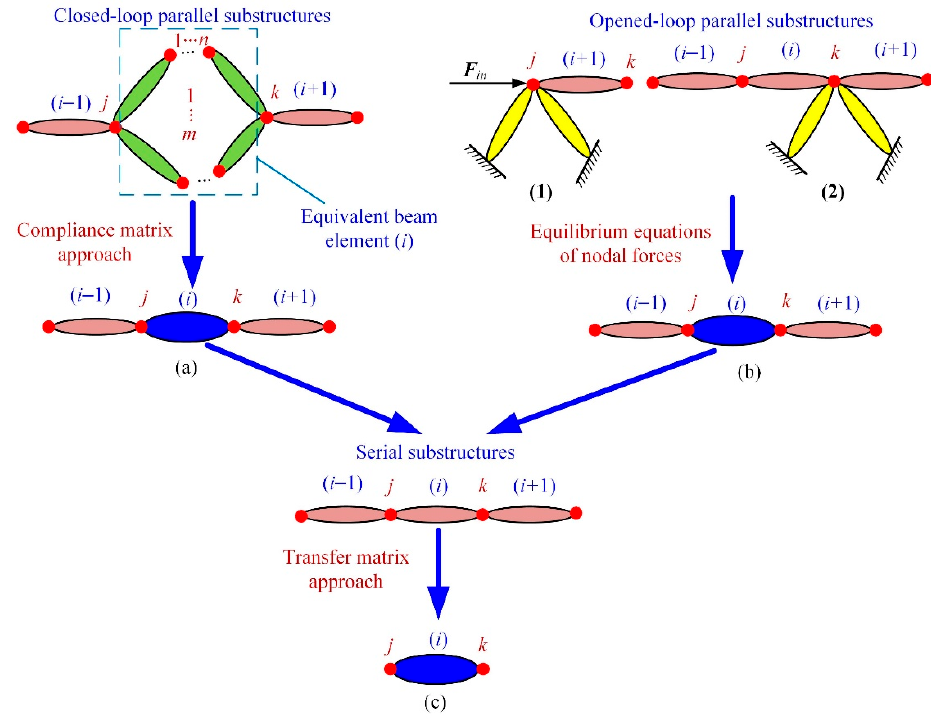
Figure 4. Illustration of serial and parallel substructures: ( a ) the closed-loop parallel substructure; ( b ) the opened-loop parallel substructure; ( c ) the series substructure.